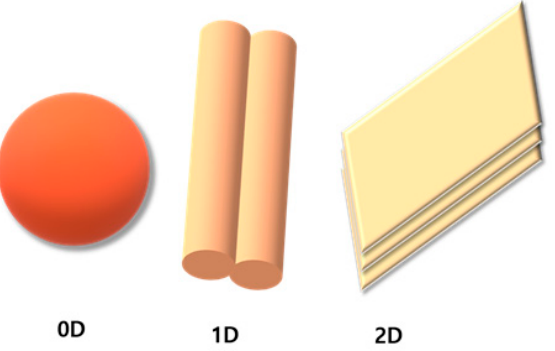
Figure 2. Graphical representation of various dimensional materials.